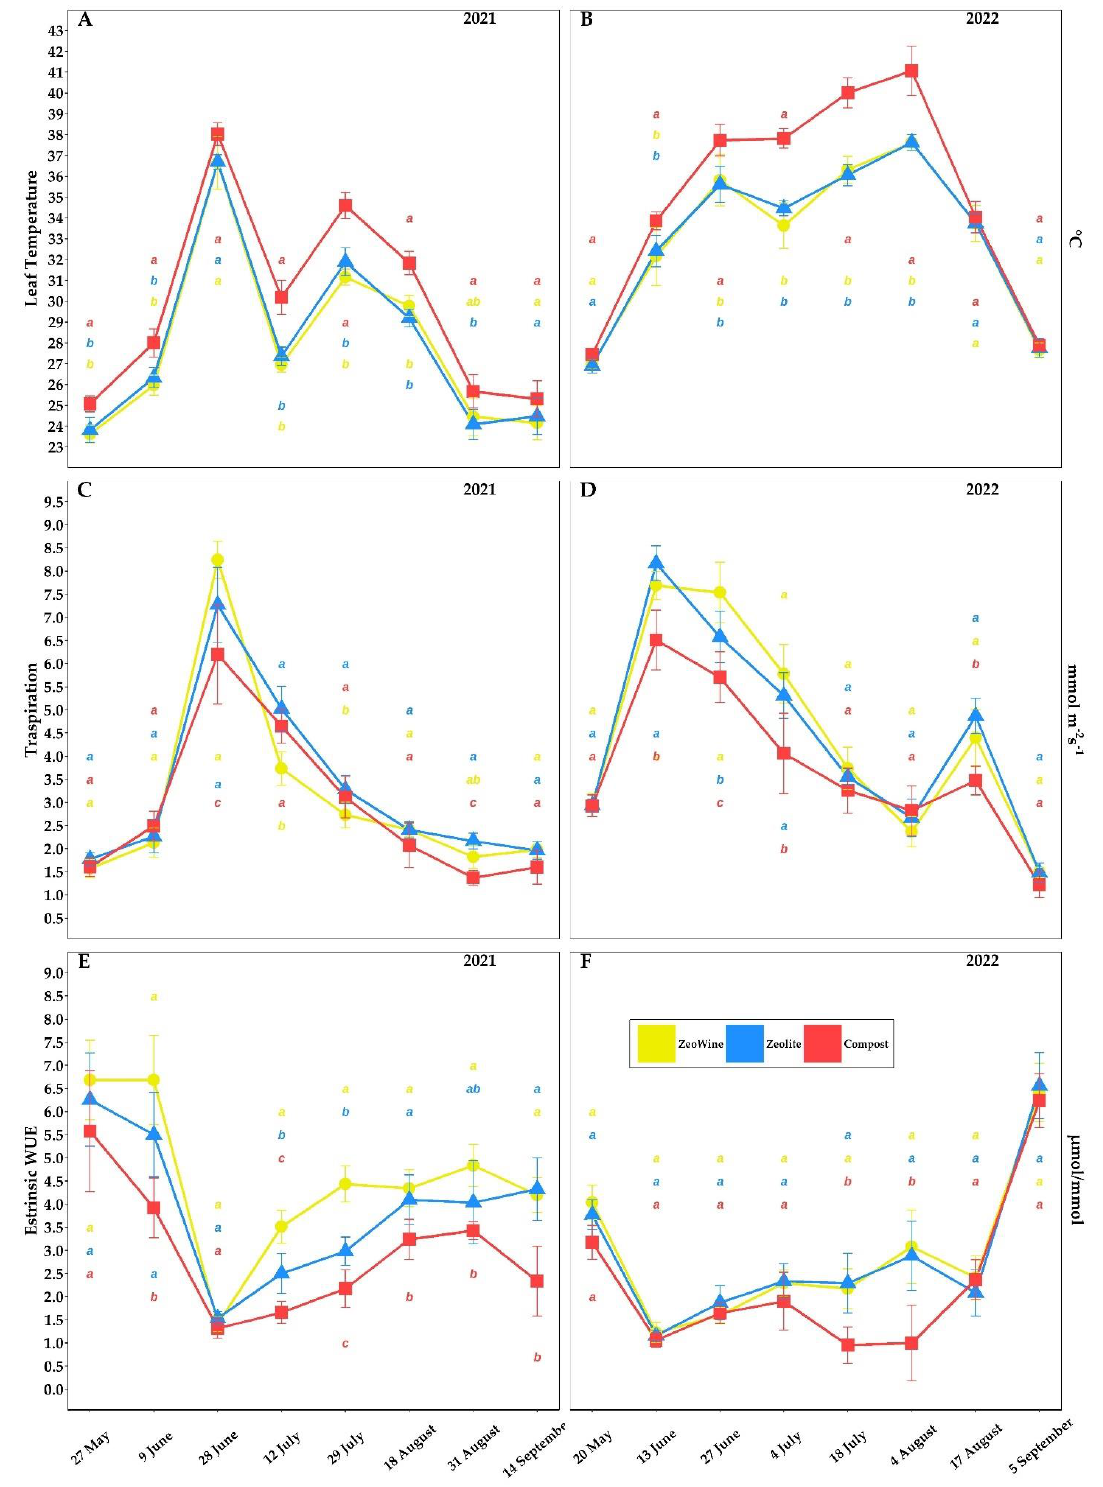
Figure 3. Physiological parameters (bis). Leaf temperature (°C), transpiration (E), and extrinsic water use efficiency (eWUE) of Vitis vinifera with three different soil management treatments. Measurements were conducted from May to September (2021 and 2022, ( A )–( F )). Data (mean ± SE, n = 10) were subjected to one-way ANOVA. The bars represent the standard deviation. Different letters indicate significant differences between Zeowine, Zeolite, and Compost (LSD test, p ≤